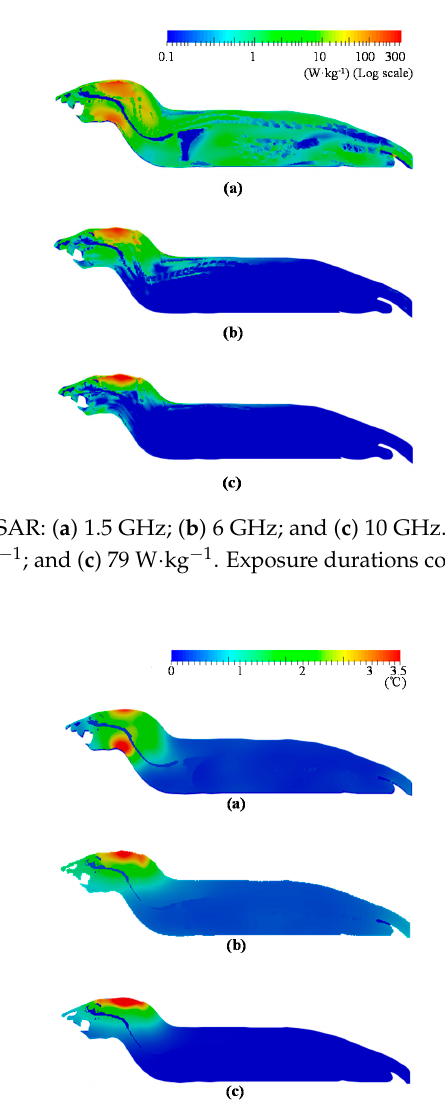
Figure 6. Distributions of maximum temperature elevation: ( a ) 1.5 GHz; ( b ) 6 GHz; and ( c ) 10 GHz. The BASARs correspond to: ( a ) 75 W·kg − 1 ; ( b ) 64 W·kg − 1 ; and ( c ) 79 W·kg − 1 . Exposure durations correspond to: 6 min in ( a ) and 18 min ( b , c ).